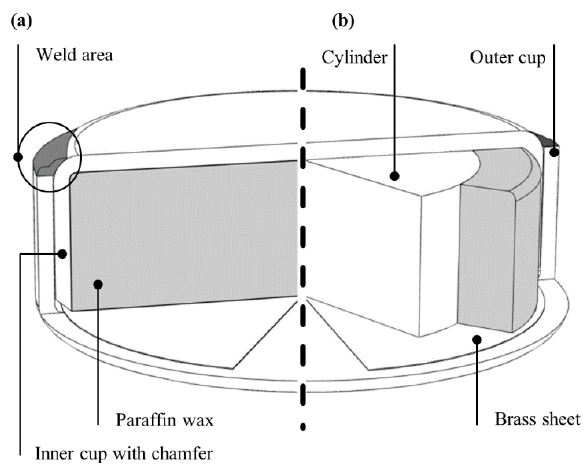
Figure 1. Design of the phase change actuator in a sectional view. Without integrated cylinder ( a ) and with cylinder ( b ).